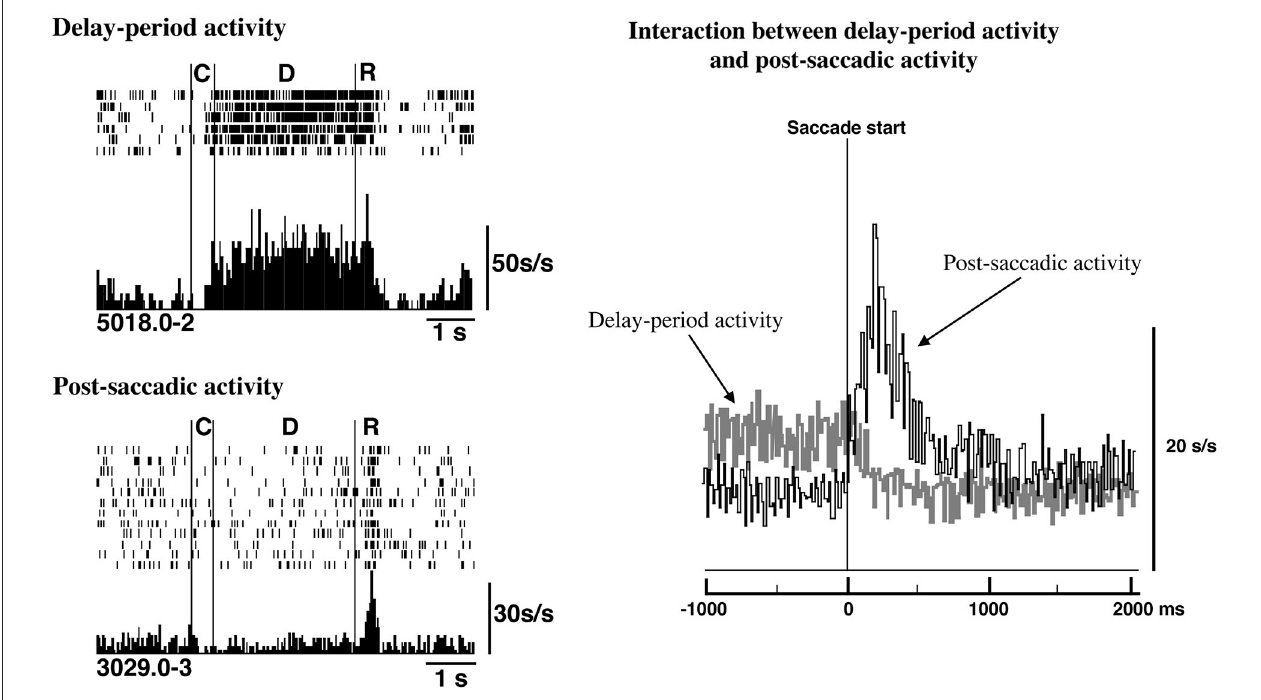
post-saccadic activity were aligned at the initiation of the saccade. The termination of delay-period activity coincided with the initiation of post-saccadic activity at a population level. Adapted from Goldman-Rakic et al.